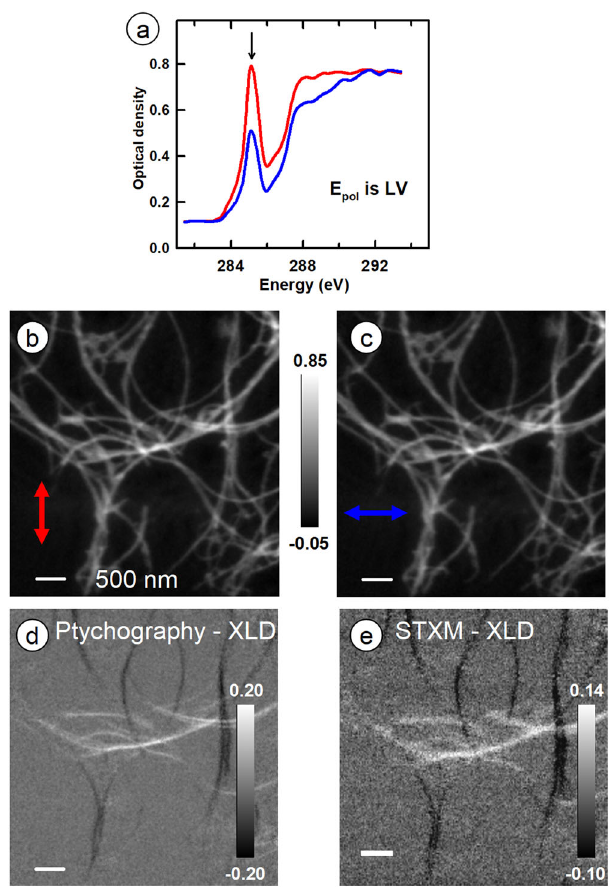
Fig. 4 Carbon K-edge spectroscopy and X-ray linear dichroic (XLD) imaging of the CNT sample. a C 1 s spectra of horizontally (red) and vertically (blue) oriented CNT, recorded with fi xed linear vertical (LV) polarization, derived from the reconstruction of a ptychographic stack (282 – 294 eV, 0.5 eV step) measured using a 1.0 μ m defocus spot. The intensity of the spectrum of the vertical CNT has been adjusted to have the same OD 293 – OD 282 value as that of the horizontal CNT. b , c OD images of the CNT sample from reconstructed amplitude images derived from 1.0 μ m defocused ptychography measured at 285.2eV, using linear vertical (LV) and linear horizontal (LH) polarizations, respectively. The optical density (OD) intensity scale applies to both ( b ) and ( c ). d X-ray linear dichroic (XLD) image (LV – LH), obtained from the corresponding ptychographic images, ( b ) and ( c ). e XLD image (LV – LH) derived from STXM images of the same area recorded using a 25 nm FZP. The intensity scales in ( d ) and ( e ) are Δ OD. Scale bar is 500 nm in all images. (see Supplementary Table 1 for acquisition